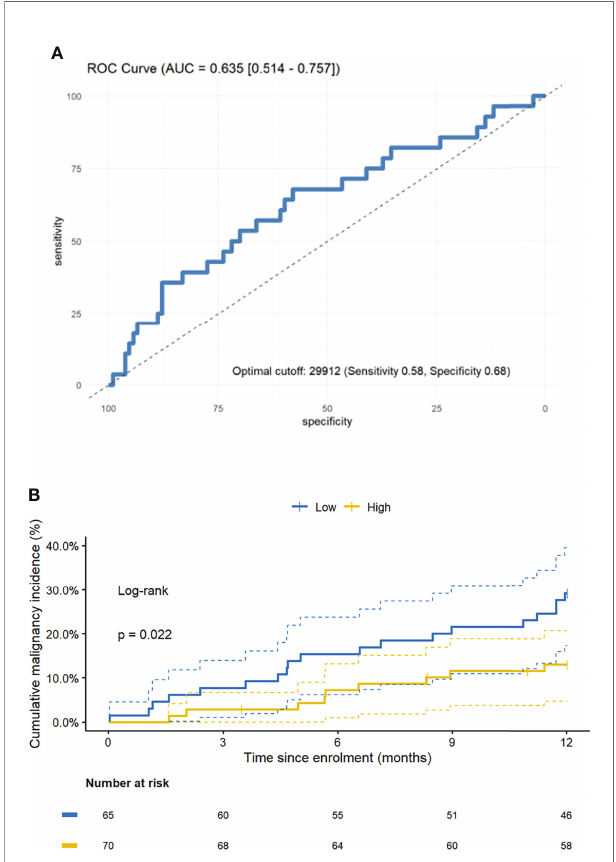
FIGURE 6 | Decreased mHLA-DRd is associated with subsequent malignancy development. (A) Receiver-operator characteristic (ROC) curve for prediction of malignancy in the year following mHLA-DRd quanti fi cation. Predictive performance is given [area under curve (AUC) and 95% con fi dence interval] as well as the optimal cut-off and corresponding sensitivity and speci fi city. (B) Kaplan-Meier curve demonstrating cumulative incidence of malignancy strati fi ed by mHLA-DRd. (unadjusted and adjusted hazard ratios and P values are given in Table 3 ; log-rank test for difference between curves is provided